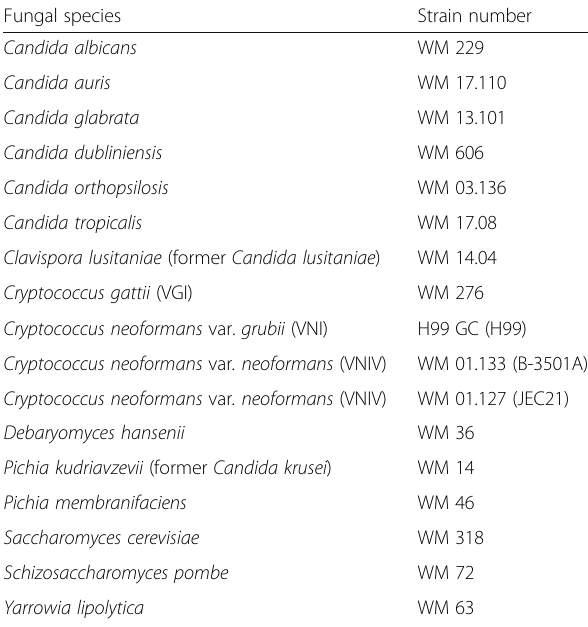
Table 1 Species and strains used to construct a mock fungal community for metatranscriptome